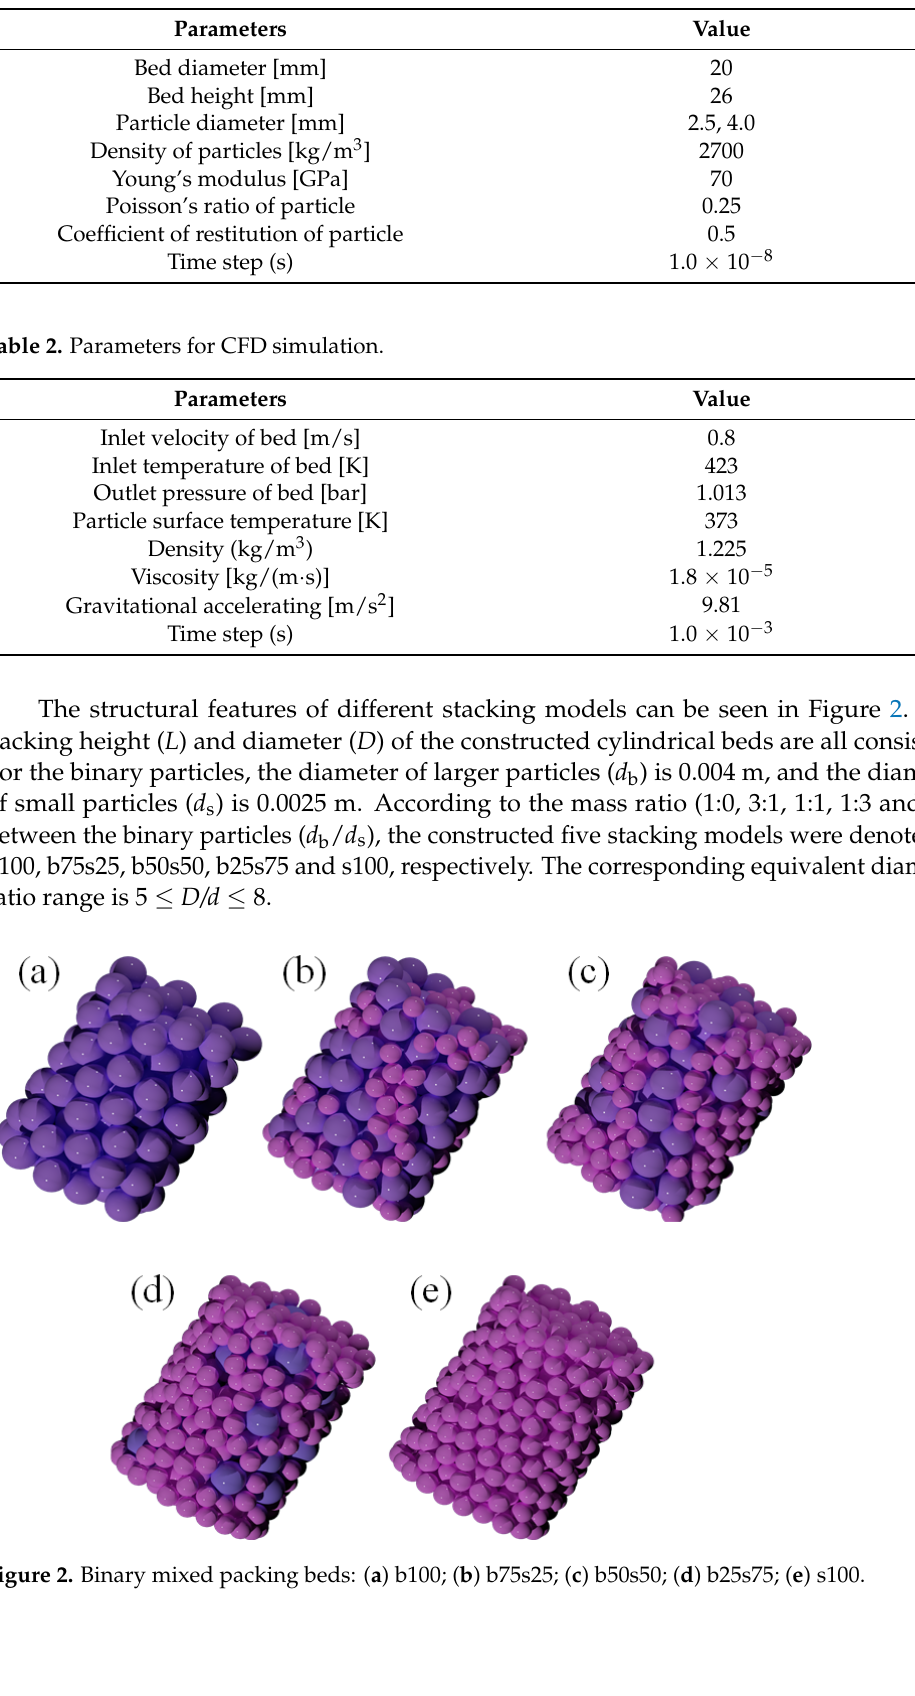
Table 1. Parameters for DEM simulation.